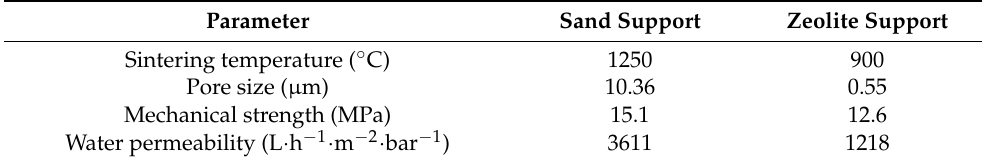
Table 2. Characteristics of sand and zeolite